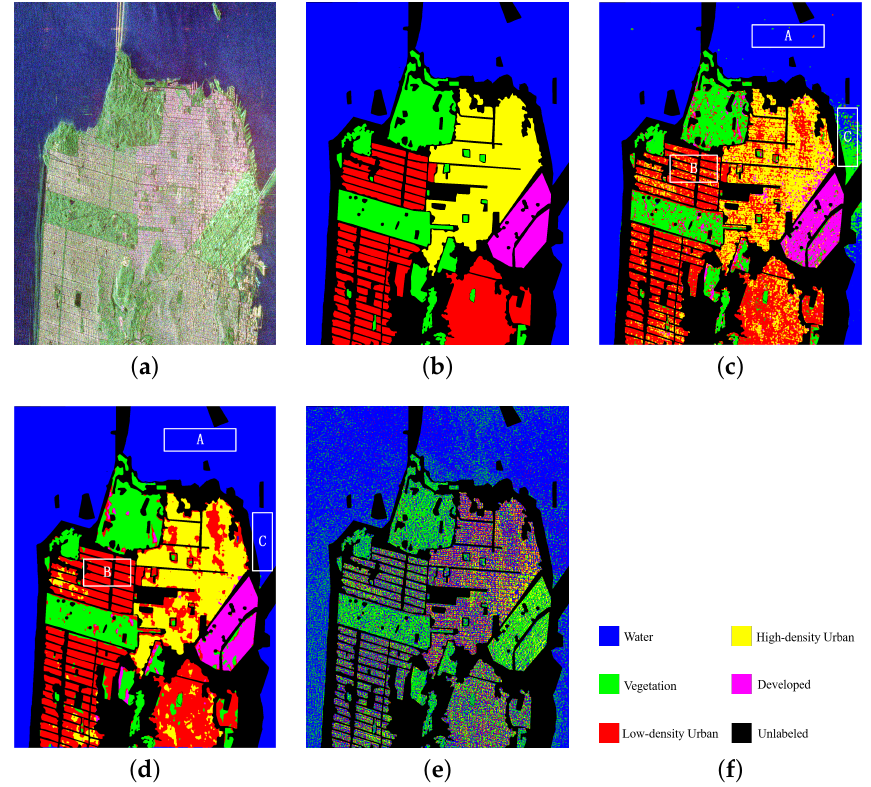
Figure 6. Experimental data of San Francisco area, ground truth of the ground object and classification results by proposed method and comparison method. Rectangles A, B and C are the specific comparative analysis areas of the classification maps in ( c , d ). ( a ) Pauli pseudo color image synthesized by single look complex data. ( b ) The ground truth of the five objects. ( c ) The classification result of H/alpha-Wishart. ( d ) The classification result of the VQC-CAE model. ( e ) The classification result of the VQC-CAE model without Gaussian smoothing loss. ( f ) The color set of the ground truth: blue for water, green for vegetation (VEG), red for high-density urban (HDU), yellow for low-density urban (LDU), magenta for developed (DEV) and the unlabeled pixels are